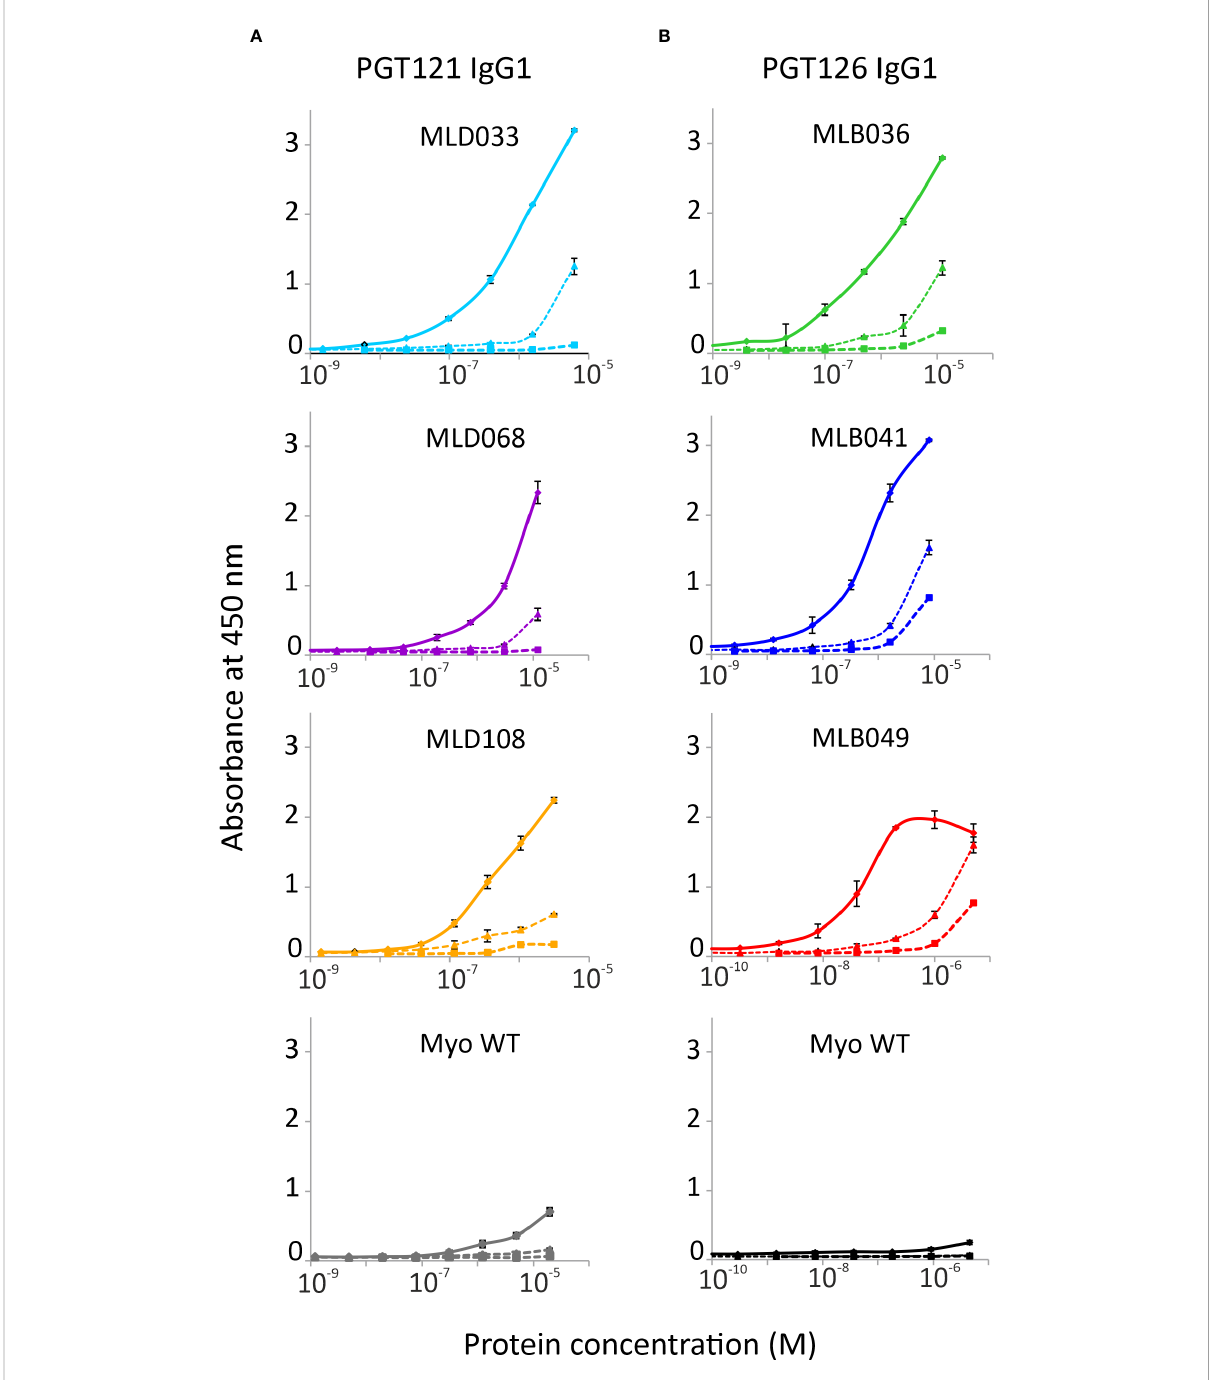
FIGURE 1 Binding of (A) MLD and (B) MLB protein variants to PGT121 and PGT126 bNAbs, respectively. The selected puri fi ed MLD proteins 033, 068 and 108, and MLB Myomedins 036, 041 and 049 with N-terminal His6-tag and C-terminal V5-tag were assayed in ELISA. Myomedin wild type (Myo WT) was added as a negative control. The binding of Myomedins to immobilized PGT121 and PGT126 bNAbs (solid line), IgG1 l isotype (dashed line with triangles) and BSA (dashed line with square) was detected by anti-V5 Ab-HRP conjugate. Each point is shown as the mean value with standard